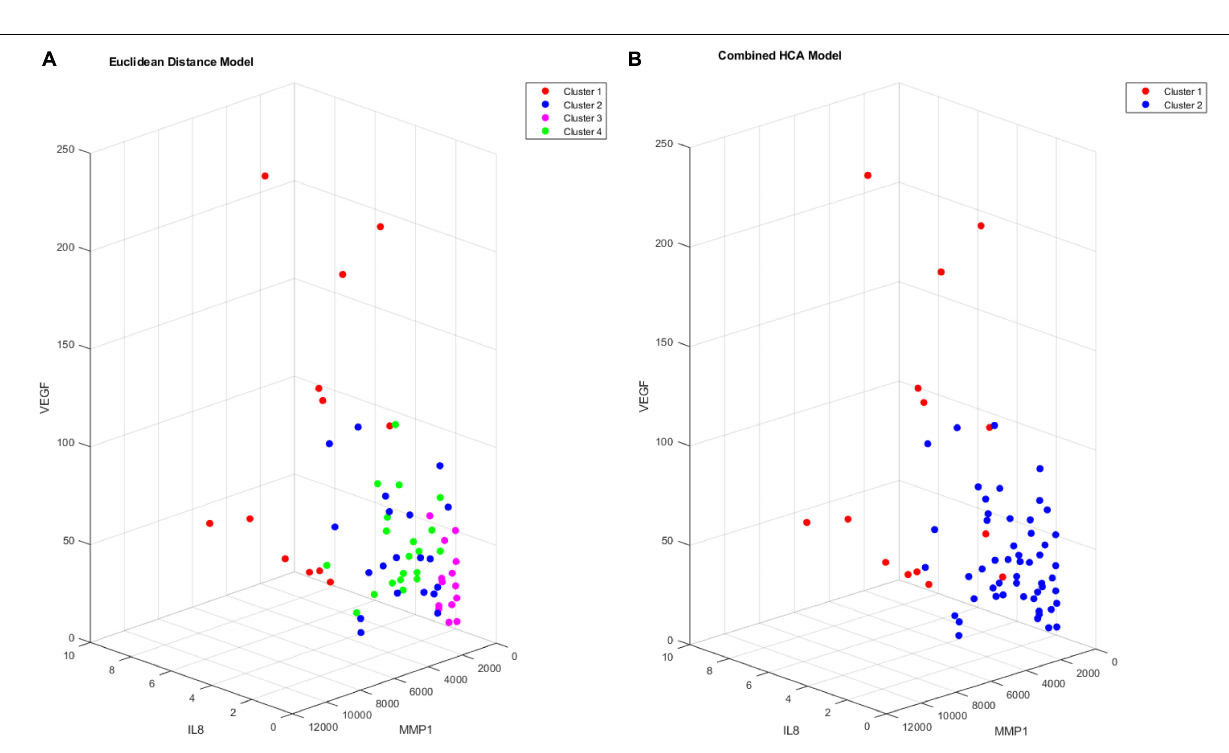
Frontiers in Neuroscience |